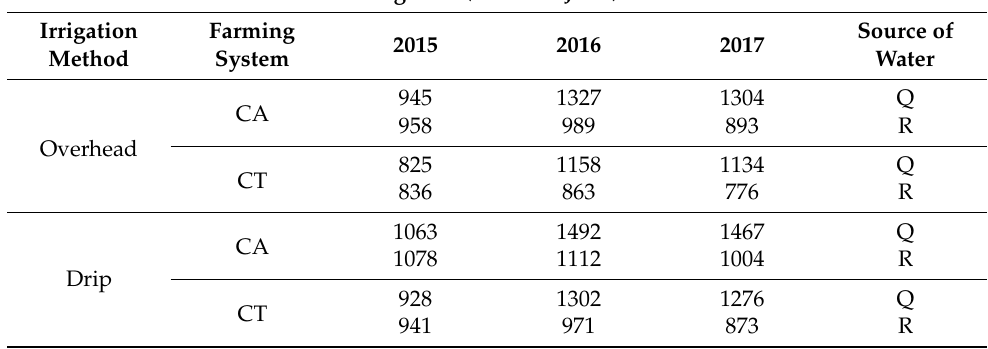
Table 4. Estimation of potentially irrigable land (ha) using groundwater recharge (R) and runoff (Q) to sustain two-season irrigation using overhead and drip water applications under